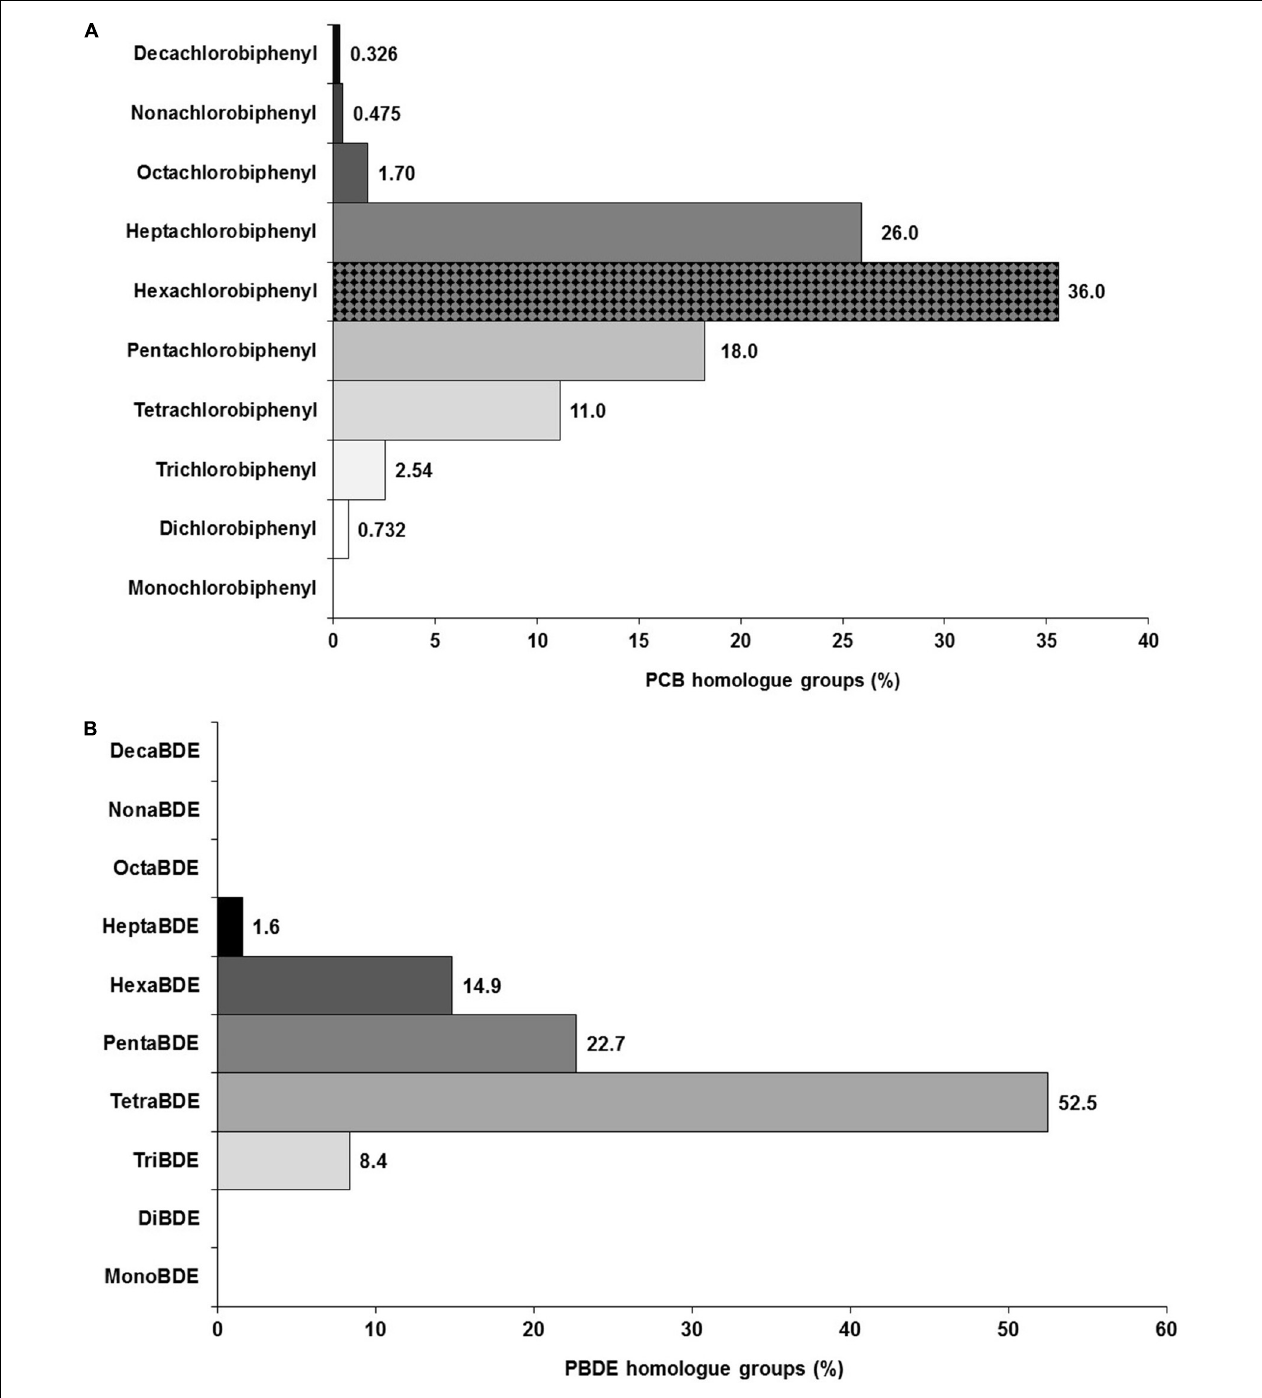
FIGURE 7 | Contribution of PCB (A) and PBDE (B) homolog groups showing the dominant patterns and distribution of lighter versus heavier homolog group signatures for both chemical classes observed in bottlenose dolphins sampled during May 2017 in El Morro Mangrove Wildlife Refuge, and Posorja Port, Gulf of Guayaquil,